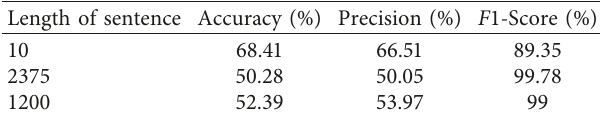
Table 5: Effect of the input statement using fixed-length six-layer